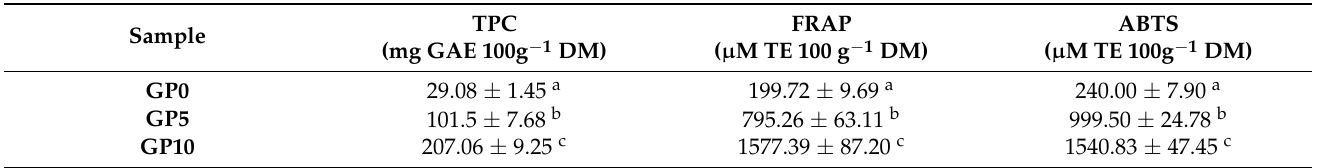
Table 7. Total phenolic compounds (TPC) and antioxidant activity (FRAP and ABTS) of control bread (GP0) and bread fortified with different percentages of grape pomace (GP5 and GP10).